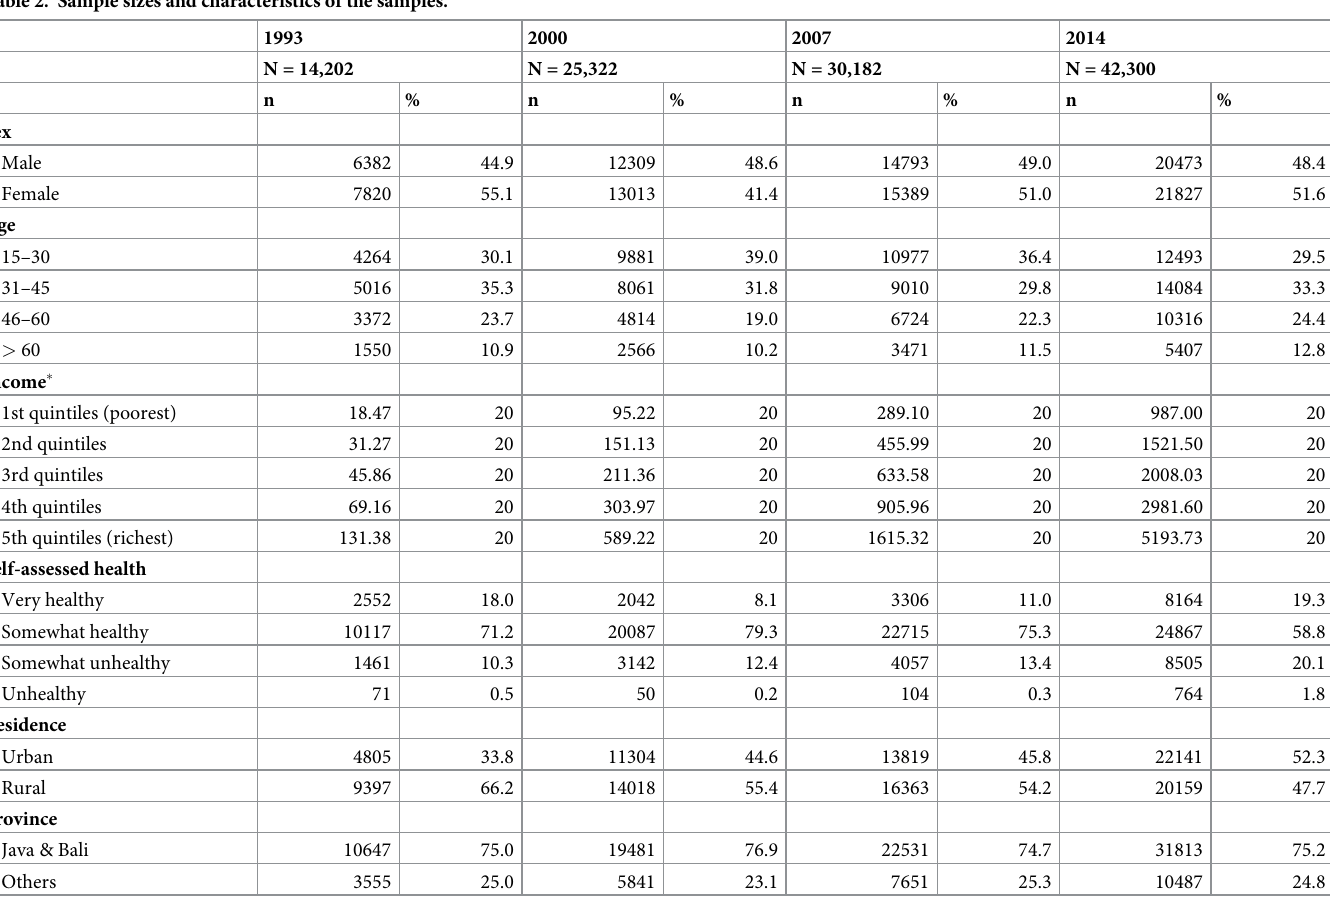
Table 2. Sample sizes and characteristics of the samples.